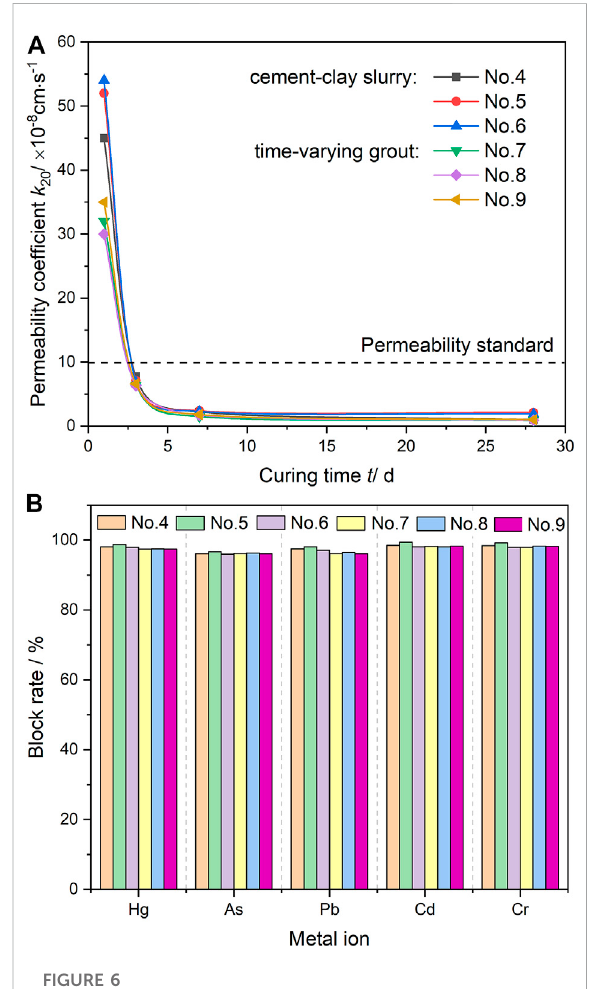
FIGURE 6 Relationship between permeability coef fi cient and curing time for the two slurries, and blocking rate for heavy metal ions.